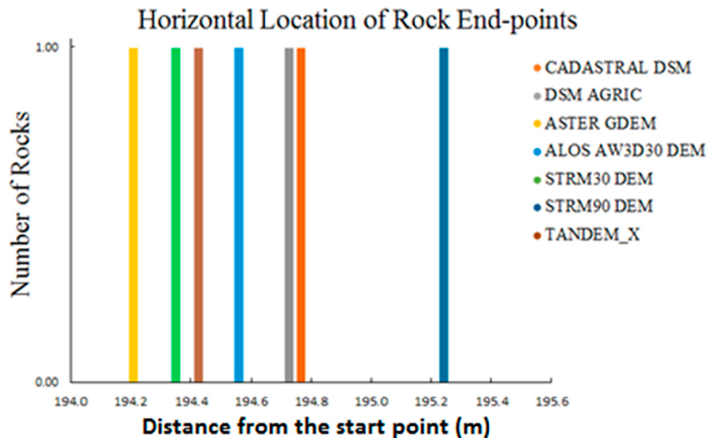
Figure 21. Horizontal location of rock end points for the 2nd slope profile from all the DSMs, except from UAV DSM.